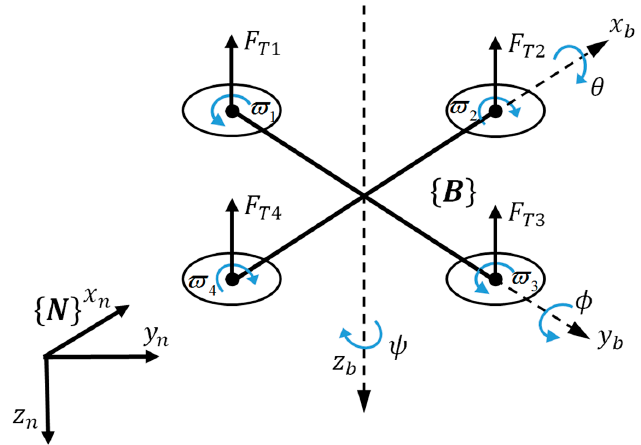
Figure 4. 6DOF motion of a rigid quadrotor with corresponding frames.